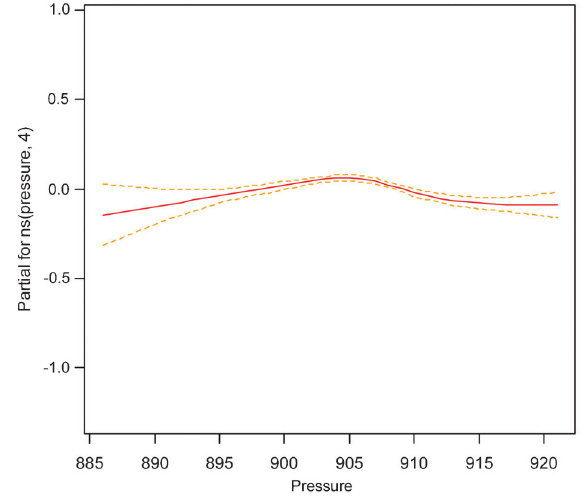
Figure 8. Effect of the day of the week (0: Sunday; 1: Monday; 2: Tuesday; 3: Wednesday; 4: Thursday; 5: Friday; 6: